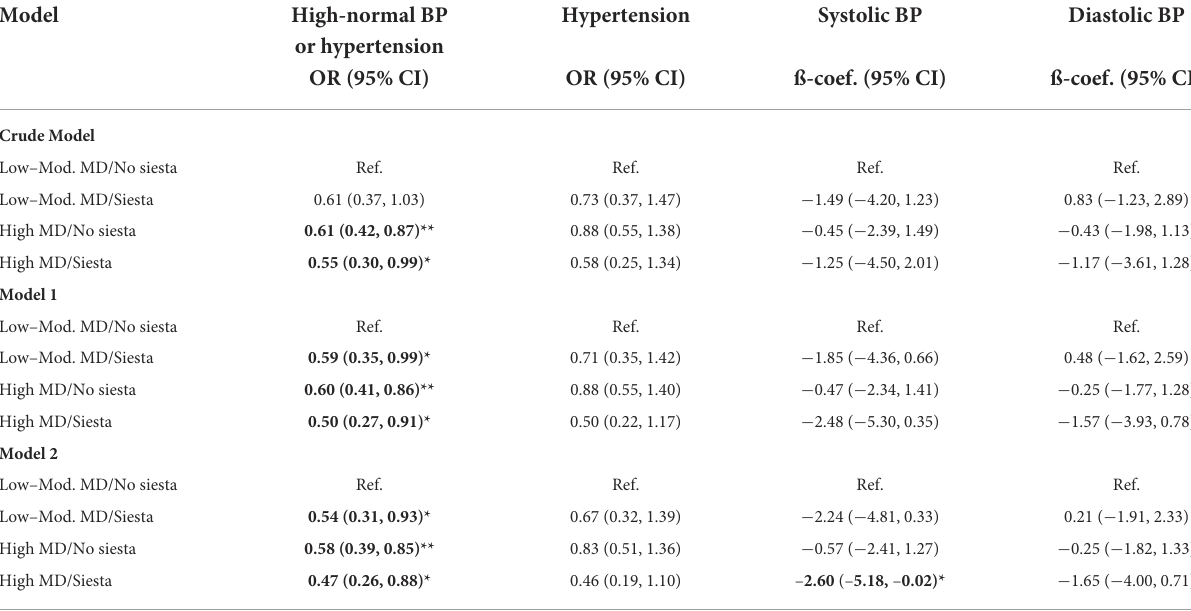
TABLE 3 Association of high-normal blood pressure or hypertension with adherence to the Mediterranean diet and siesta in combination.